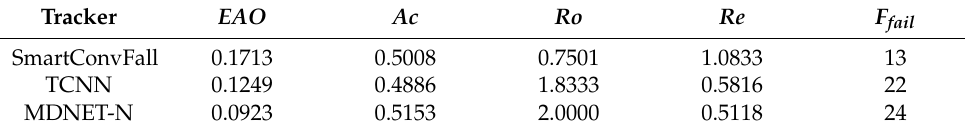
Table 13. Performance comparison of all tested trackers for the occlusion noise attribute.